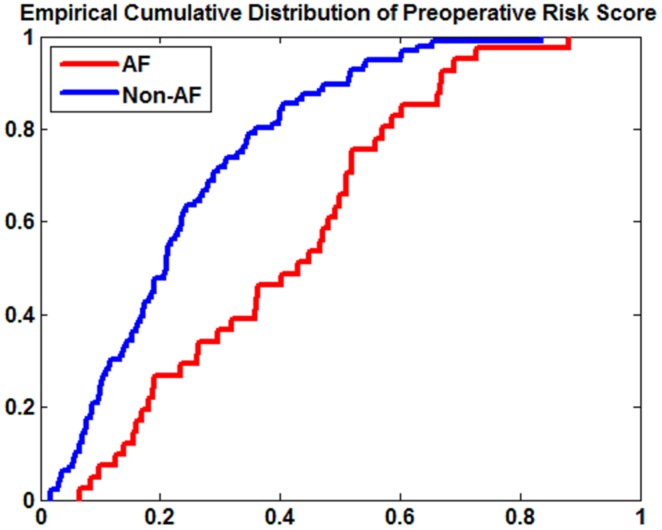
The empirical CDF (cumulative distribution function) of preoperative risk score of AF and Non-AF groups.